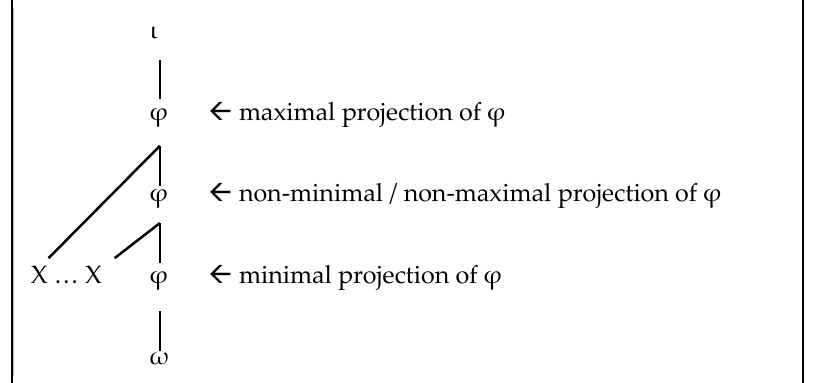
Figure 2. Recursion-based subcategories of φ (according to Itô and Mester 2012, 2013).